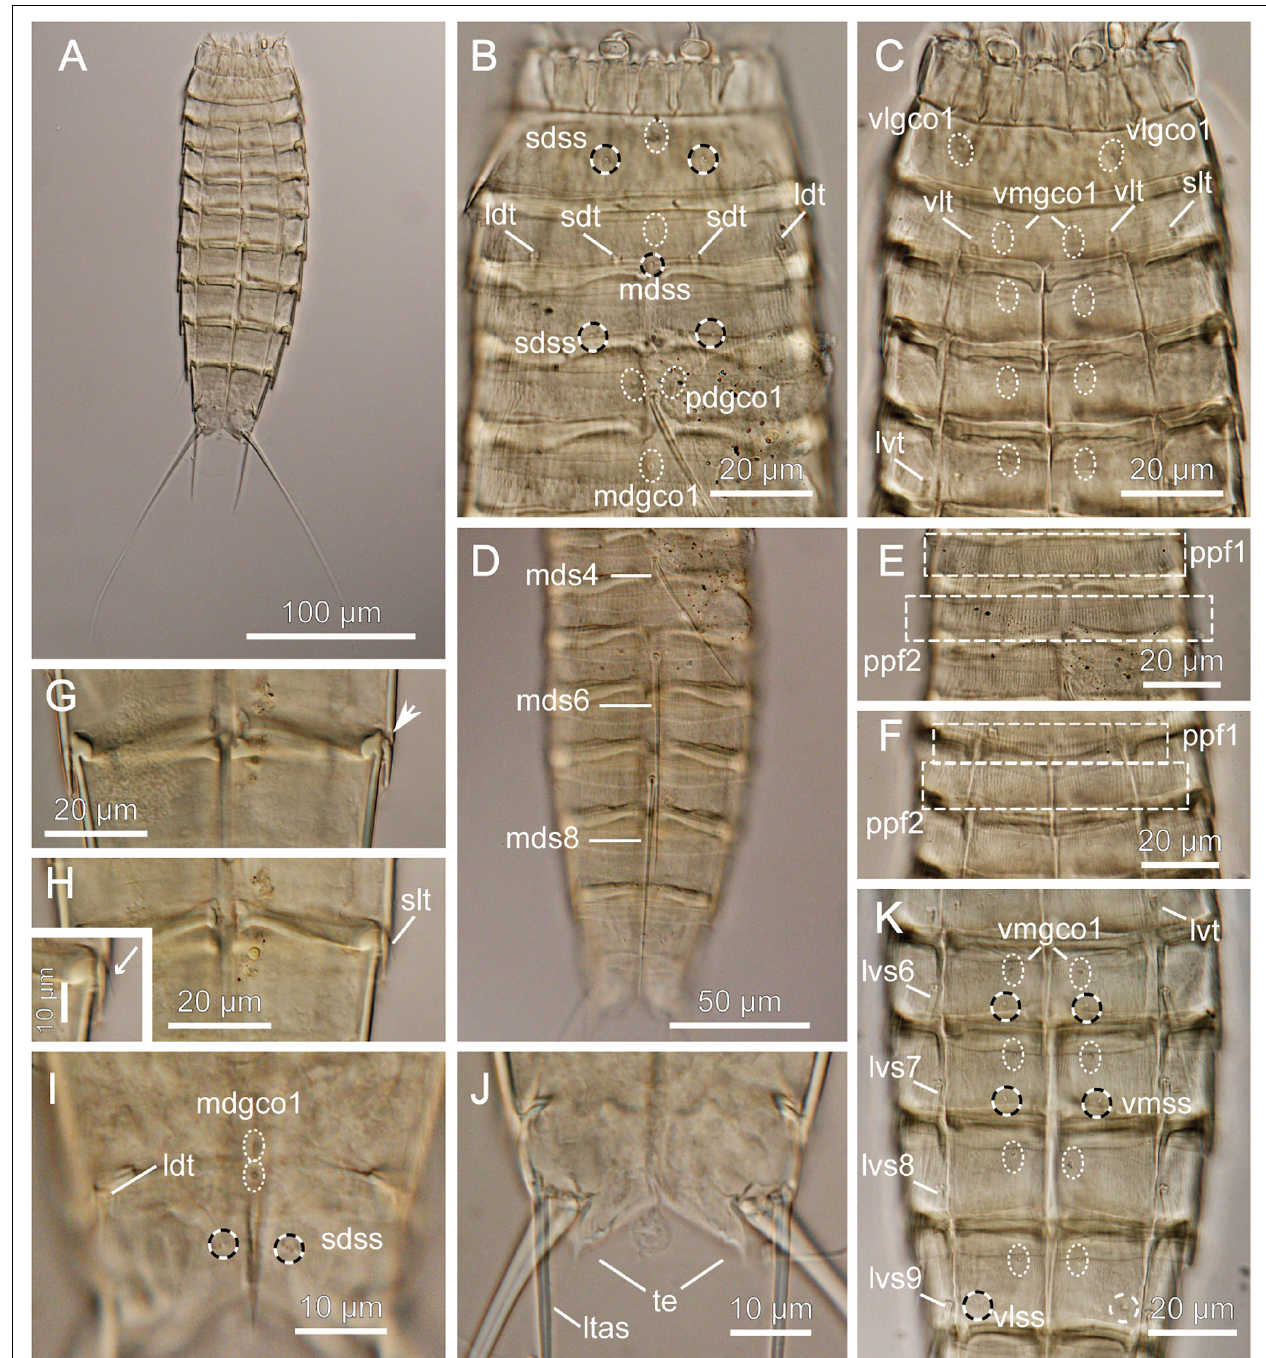
FIGURE 9 | Light micrographs showing overview and details of female Echinoderes sp. 3 (NHMD-872651) collected at station 1. (A) Ventral overview. (B) Segments 1 to 5, dorsal view. (C) Segments 1 to 5, ventral view. (D) Segments 4 to 11, dorsal view. (E) Segments 2 to 4, dorsal view. (F) Segments 2 to 4, ventral view. (G) Segments 8 to 9, ventral view. (H) Segments 8 to 9, ventral view with close-up showing sublateral tube. (I) Segments 10 to 11, dorsal view. (J) Segment 11, ventral view. (K) Segments 5 to 9, ventral view. ldt , laterodorsal tube; ltas , lateral terminal accessory spine; lvs , lateroventral spine, followed by segment number; lvt , lateroventral tube; mdgco1 , middorsal glandular cell outlets type 1; mds , middorsal spine, followed by segment number; pdgco1 , paradorsal glandular cell outlets type 1; ppf , primary pectinate fringe, followed by segment number; sdss , subdorsal sensory spot; sdt , subdorsal tube; slt , sublateral tube; te , tergal extension; vlgco1 , ventrolateral glandular cell outlets type 1; vlss , ventrolateral sensory spot; vlt , ventrolateral tube; vmgco1 , ventromedial glandular cell outlets type 1. Arrow in G shows sublateral interruption.